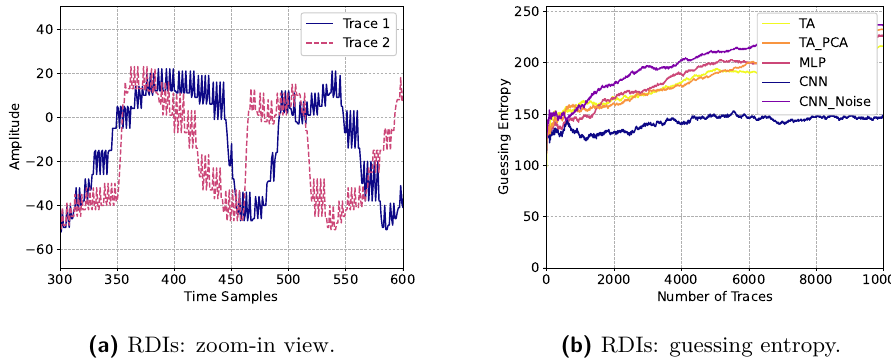
(b) RDIs: guessing entropy. Figure 5: RDIs: demonstration and its influence on guessing